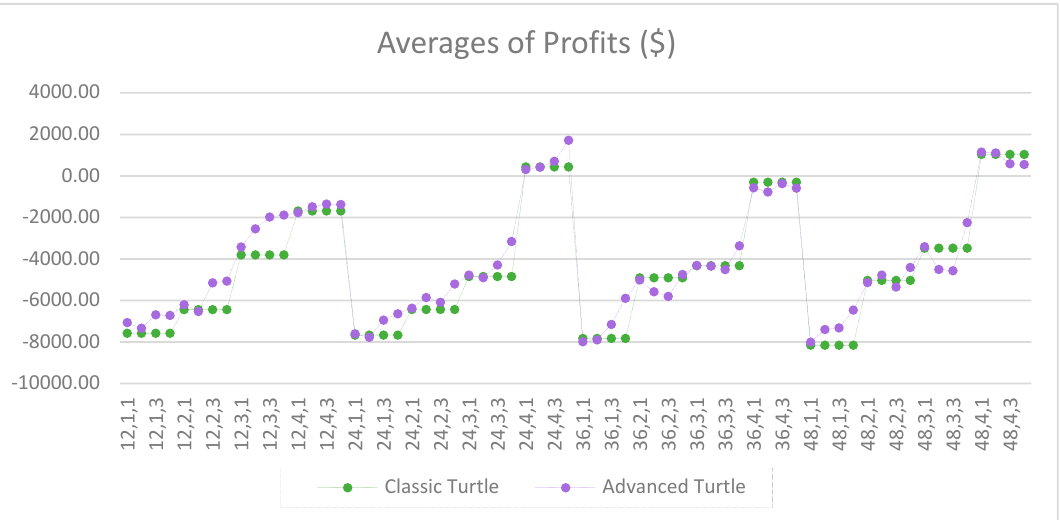
Figure 10. Averages of drawdowns as percentage of equity between the classic and the advanced Turtle systems for every combination of N, X, Y for the fast parameters (20, 40).